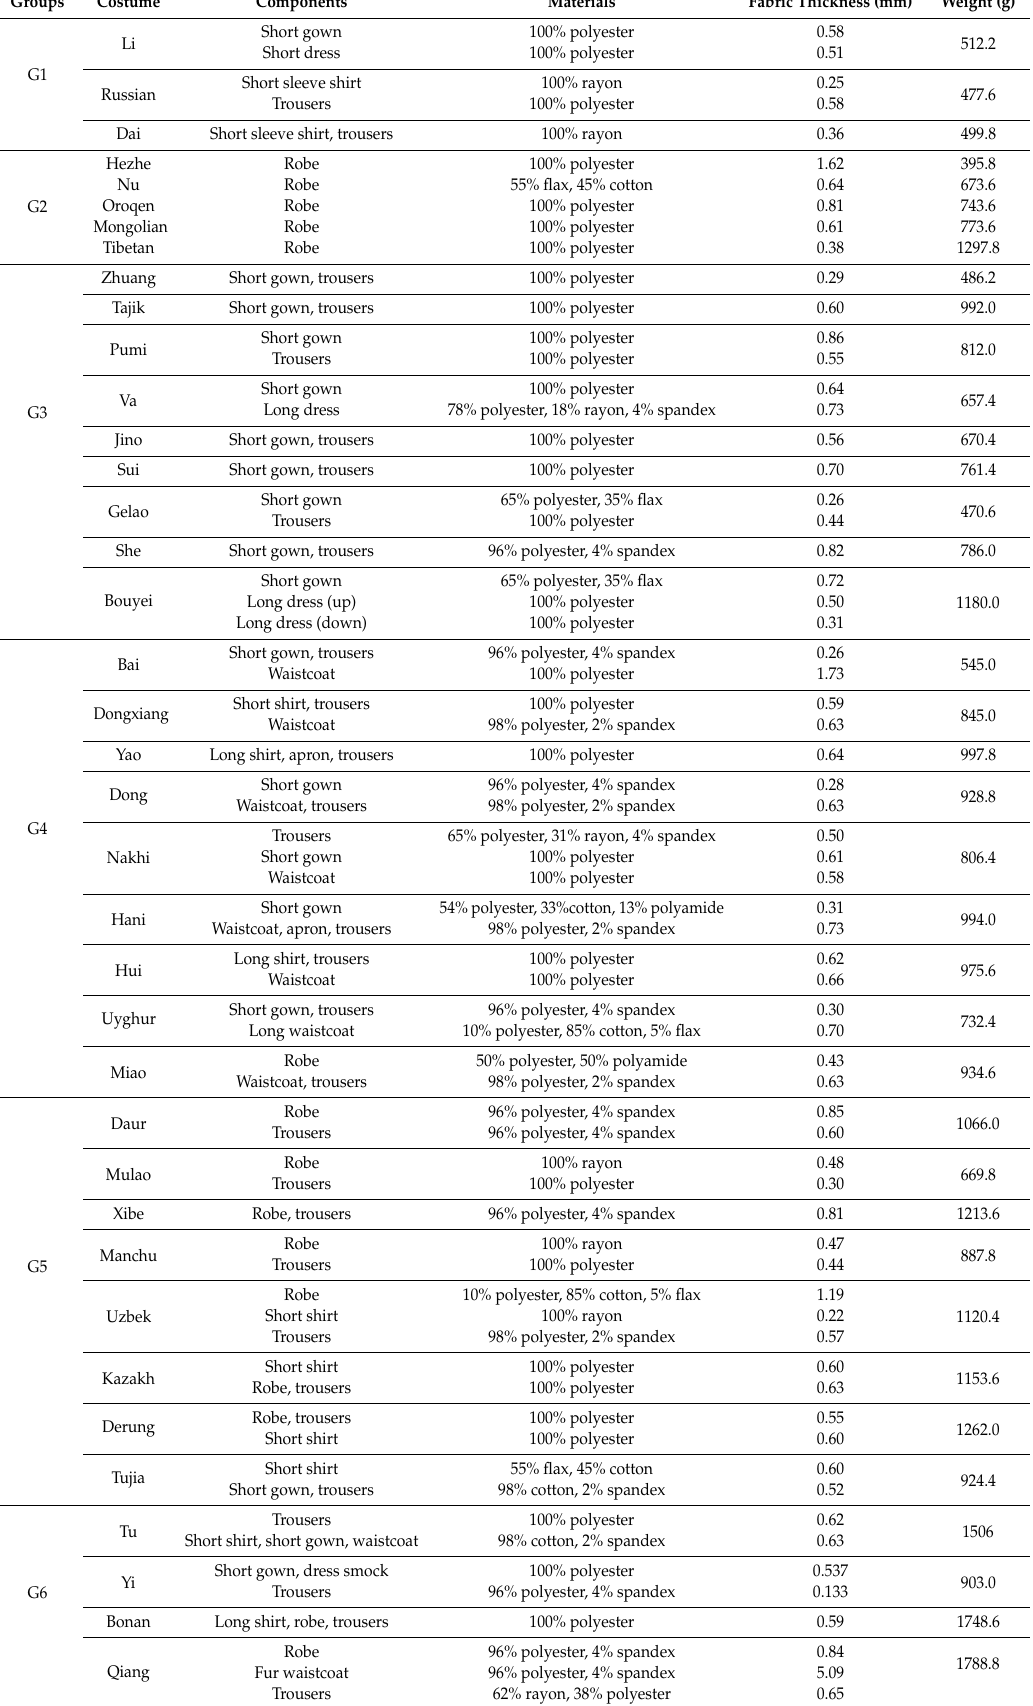
Table 1. Characteristics of the 39 sets of male minority ethnic